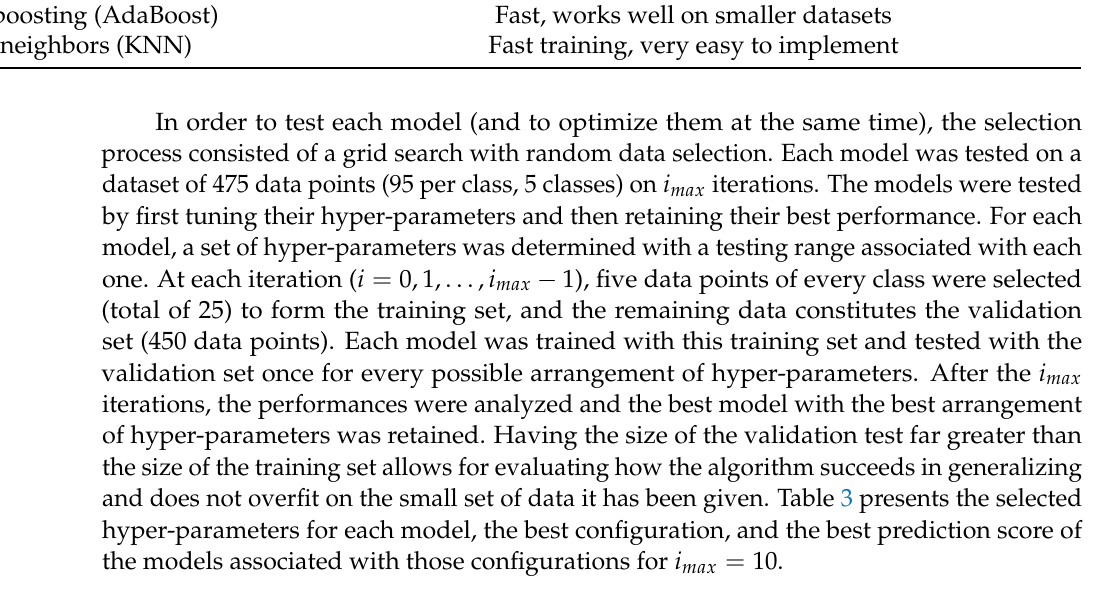
Table 3. Evaluations of the machine learning models, in function of their hyper-parameters’